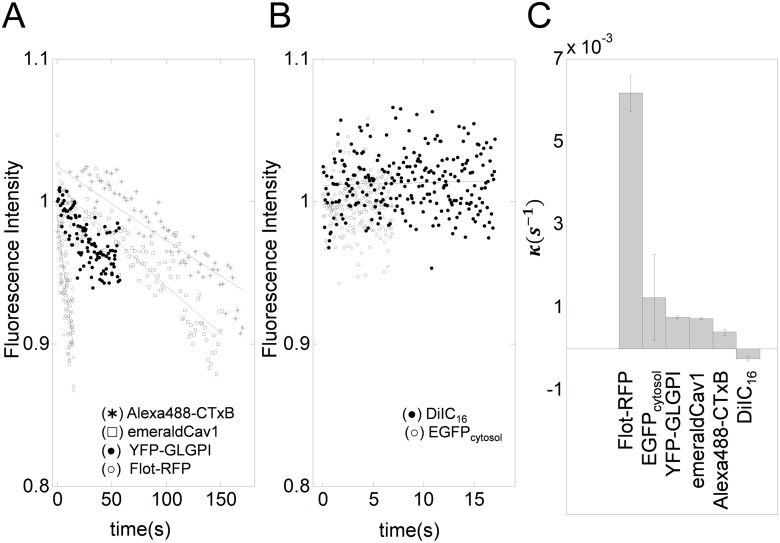
Representative photofading rates obtained from the whole image fluorescence for a variety of different fluorescently tagged molecules.A photofading model, f(t) = e
−κt was fitted to normalized whole image fluorescence data F
Data(t)/F
i averaged over multiple data sets (n = 10) for each of the indicated fluorescent proteins or fluorescent lipid probes. (A–B) Best fitting photofading model applied to whole image fluorescence. Solid lines show the best fitting curves. (C) Photofading rate constants obtained from the fits shown in A and B are shown in descending order. Error bar represents the standard deviation (n = 14).